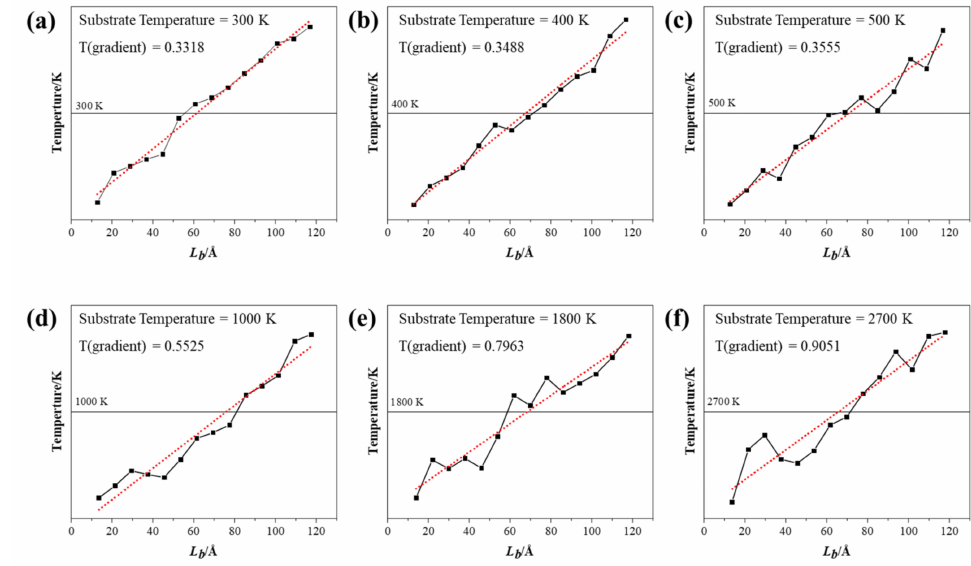
Figure 4. The temperature distribution and temperature gradient at ( a ) 300 K, ( b ) 400 K, ( c ) 500 K, ( d ) 1000 K, ( e ) 1800 K and ( f ) 2700